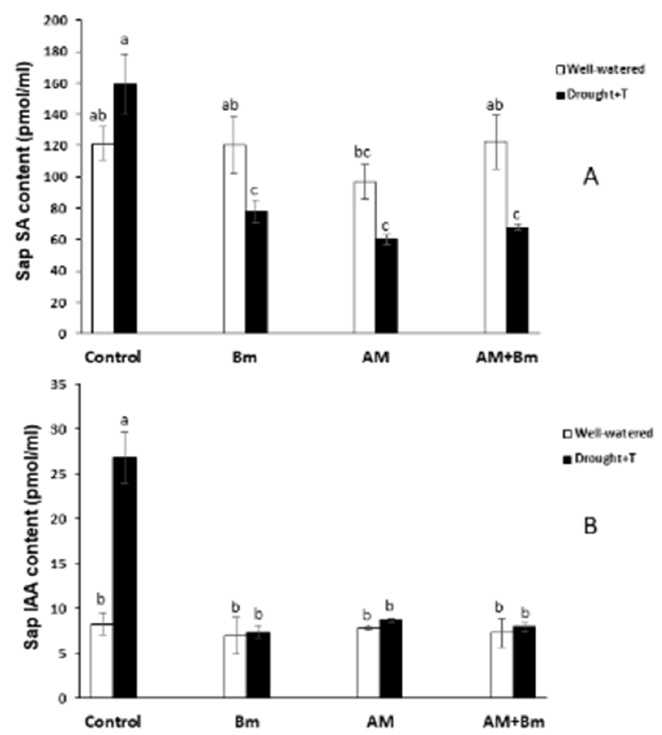
Figure 9. ( A ) SA and ( B ) IAA contents in sap of maize plants inoculated or not (control) with a PGPR strain of Bacillus megaterium (Bm), with the arbuscular mycorrhizal fungus Rhizophagus irregularis (AM) or with both microorganisms (AM + Bm). Plants were cultivated under standard ambient tem ‐ perature and well ‐ watering conditions (well ‐ watered) or subjected to a combined drought and high temperature stress (drought + T) for 15 days before harvest. Data represent the means (n = 8) ± S.E. Different letters indicate significant differences between treatments ( p < 0.05) based on Duncan’s test.